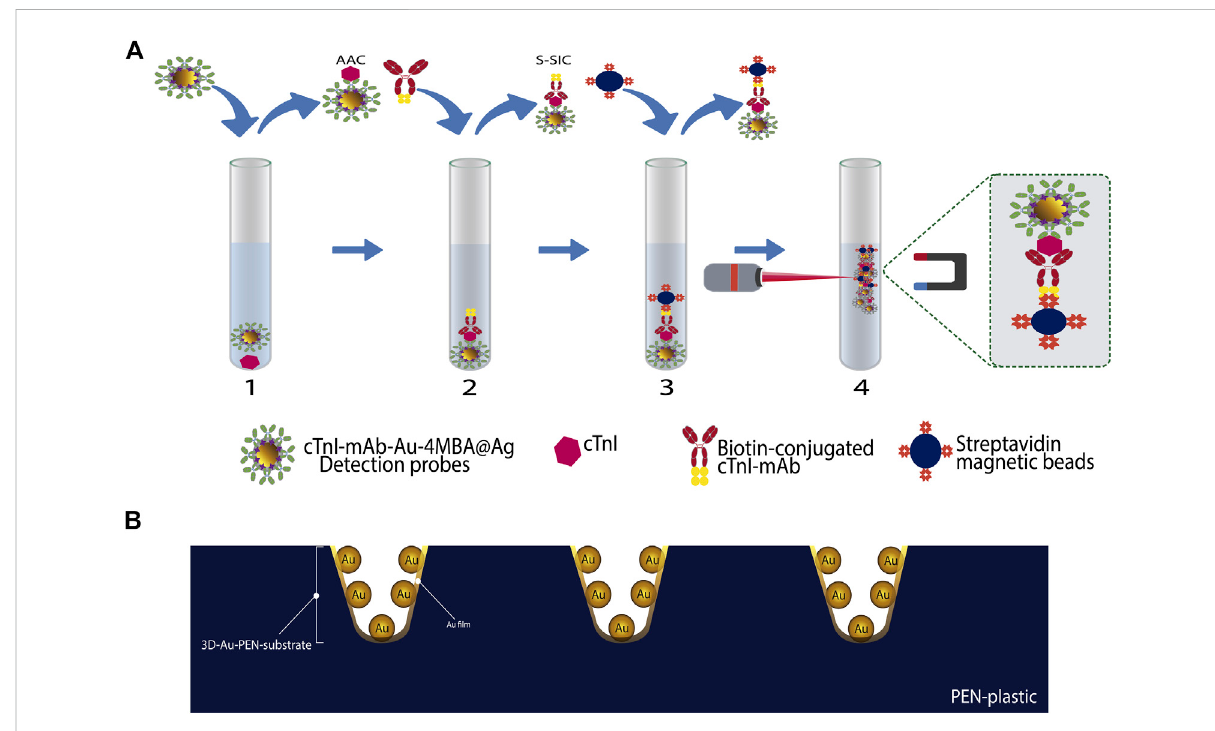
FIGURE 6 SchematicrepresentationofdifferentcTnIdetectionsystemsworkinginsolution. (A) sandwichimmunoassay,adaptedfromHuetal.(2021)and (B) 3D AuNPs-PEN substrate, adapted from Lee et al.